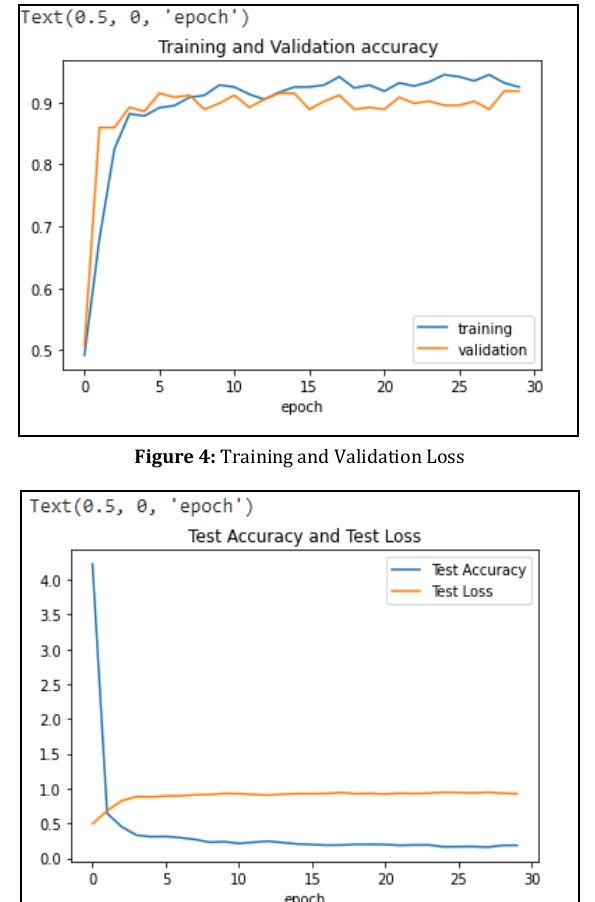
Figure 3: Training and Validation Loss